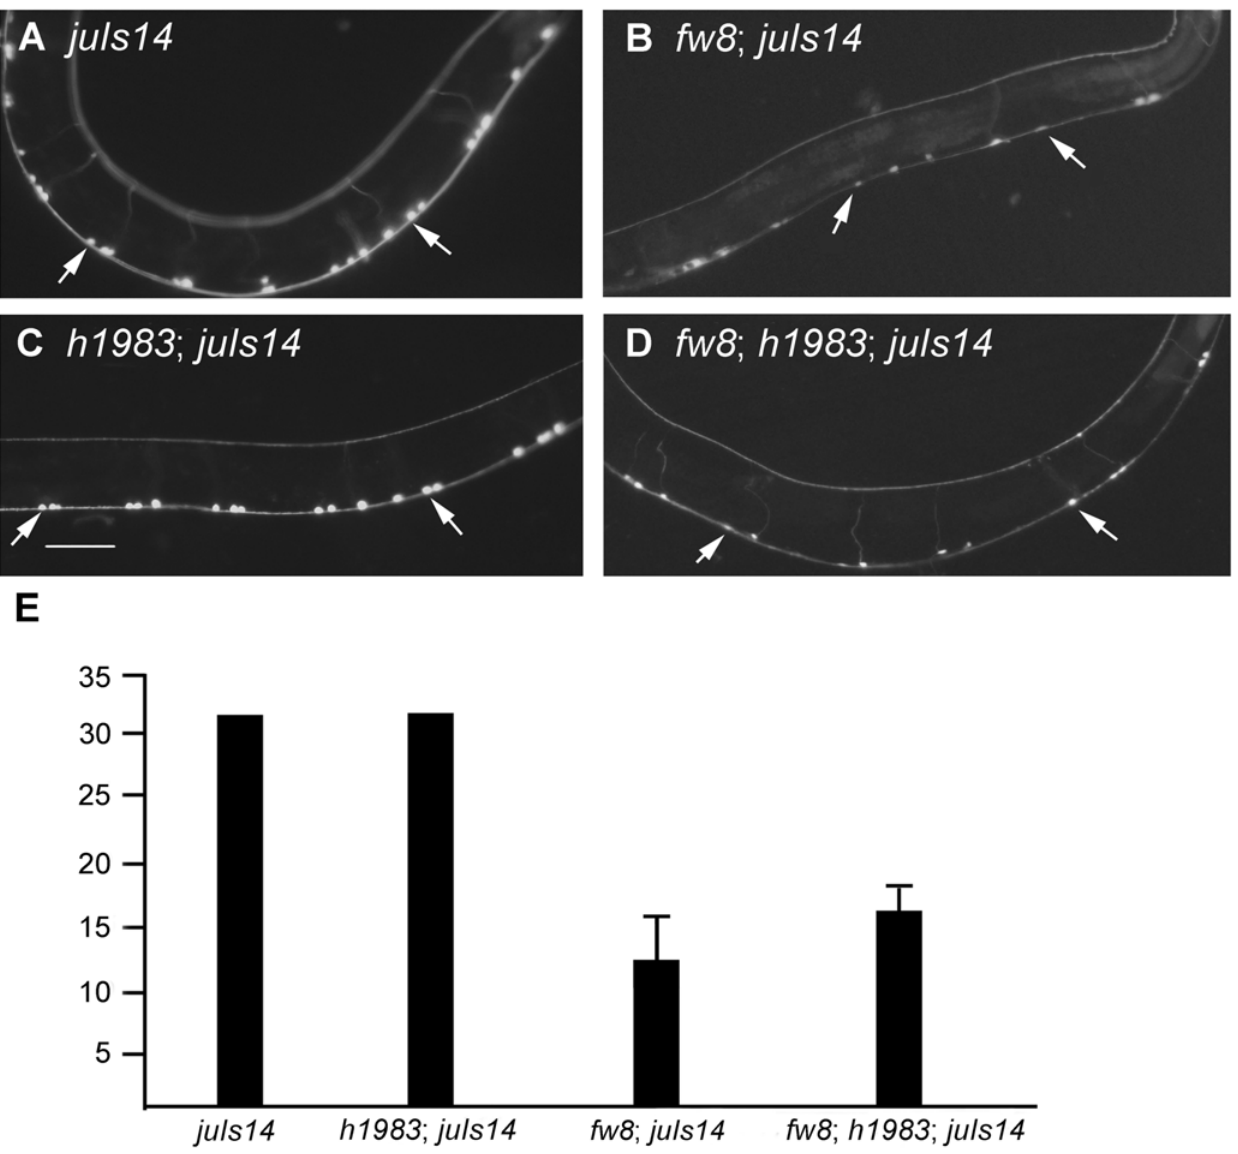
Figure 8. Weak Allele of fzy-1 ( h1983 ) Suppressed Neuron Decrease Phenotype of bub-1 ( fw8 ). (A) juIs14 [P acr-2::GFP ] strain visualizes A and B-type neurons, (B) bub-1 ( fw8 ) had less A and B type neuron. (C) fzy-1 ( h1983 ) did not affect A and B-type neuron fate. (D) fzy-1 ( h1983 ) could partially suppress bub-1 ( fw8 ) in neuron counting number. Arrows indicate some of the A and B-type neurons. The bar represents 50 m m. (E)Y axis shows the A and B-type neuron numbers (not including neurons in the head ganglia). Error bars represent standard deviation (the t-test compared to control fw8 ; juIs14 : P , 0.001).